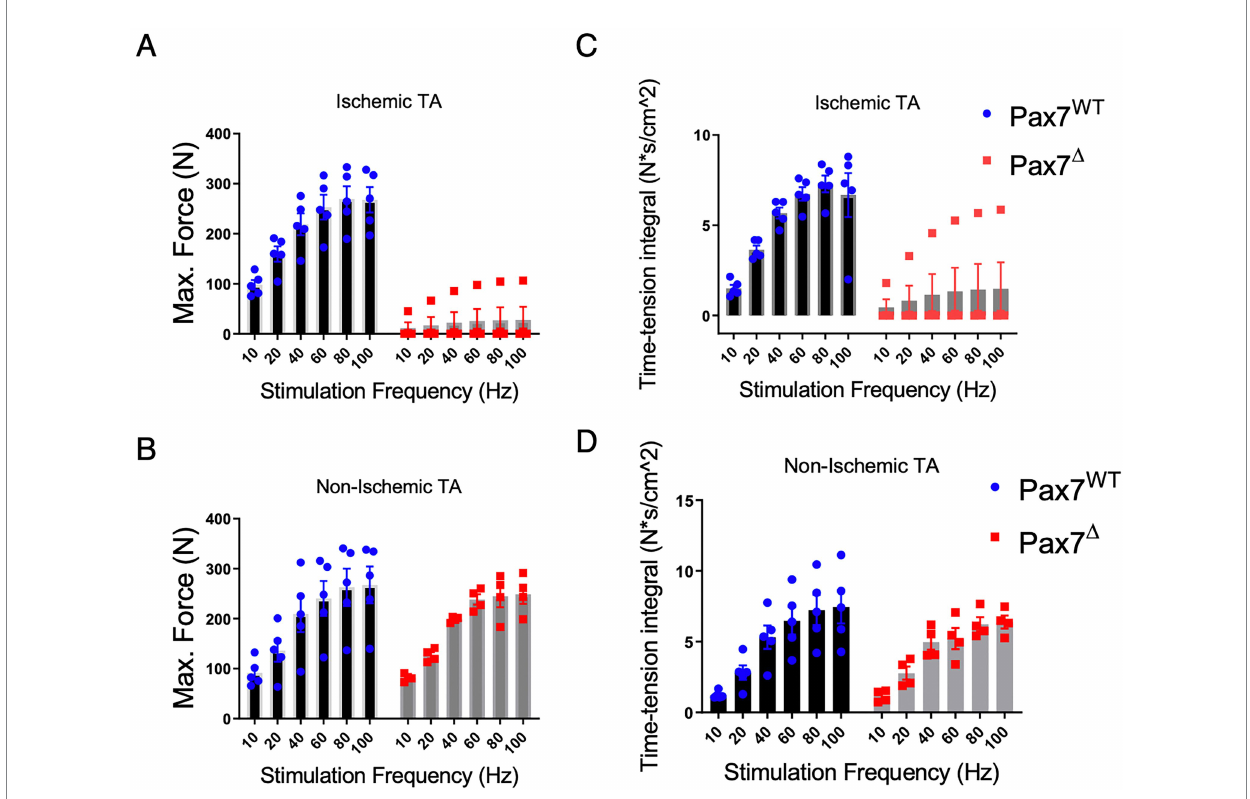
FIGURE 4 Pax7 + MPC ablation impairs force generation 30 days after HLI. (A) The maximum force generated by the ischemic EDL muscle was significantly lower ( p < 0.0001 by 2-way ANOVA) in Pax7 Δ mice. (B) Maximum force was unchanged in the non-ischemic limb of Pax7 Δ mice. (C,D) The time-tension integral, a measure of work done in a single contraction, of muscle 30 days after HLI mirrored the maximum force data in both ischemic (C) and non- ischemic TA muscle (D) ( n = 4–5 per